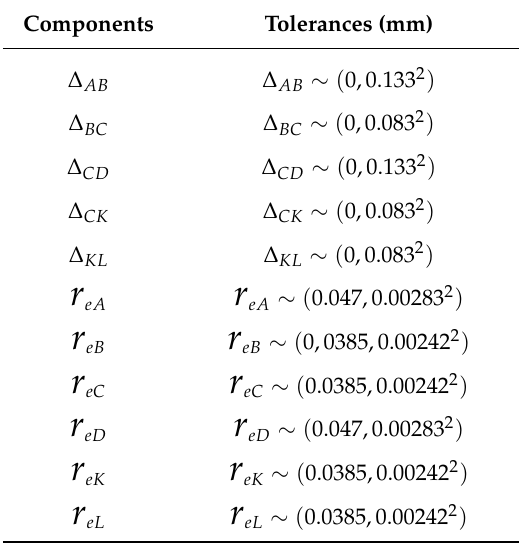
Table 4. Primary tolerance design parameters.